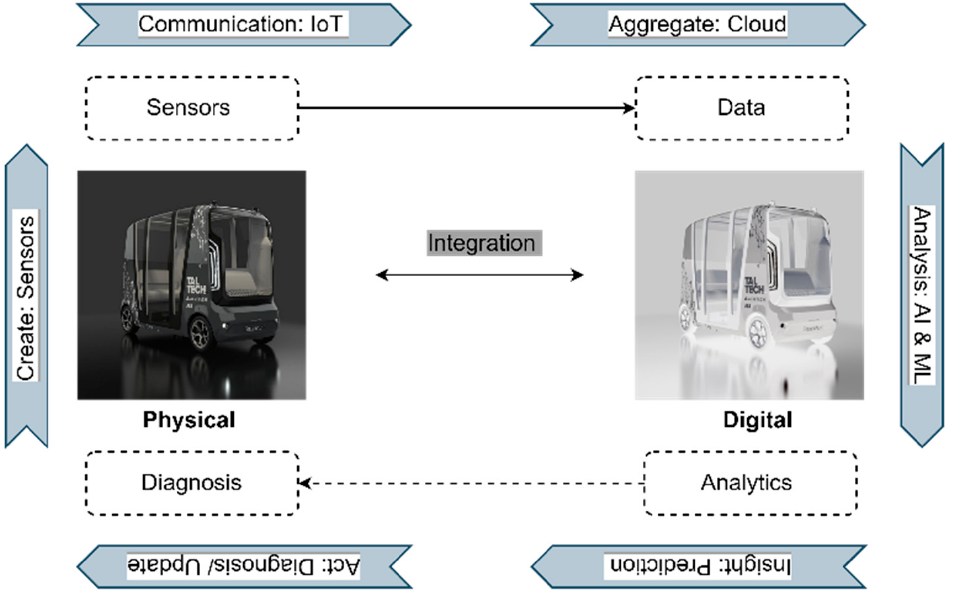
Figure 1. Systematic Characteristics of DT.